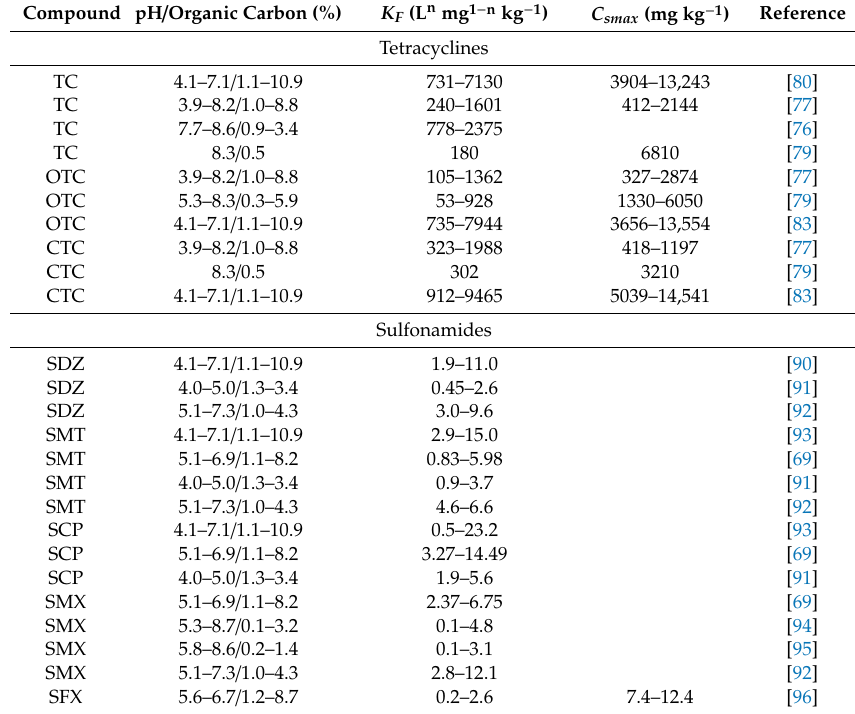
Table 7. Values for the Freundlich’s a ffi nity coe ffi cient ( K F ) and maximum adsorption capacity of Langmuir ( C smax ) for tetracycline and sulfonamide